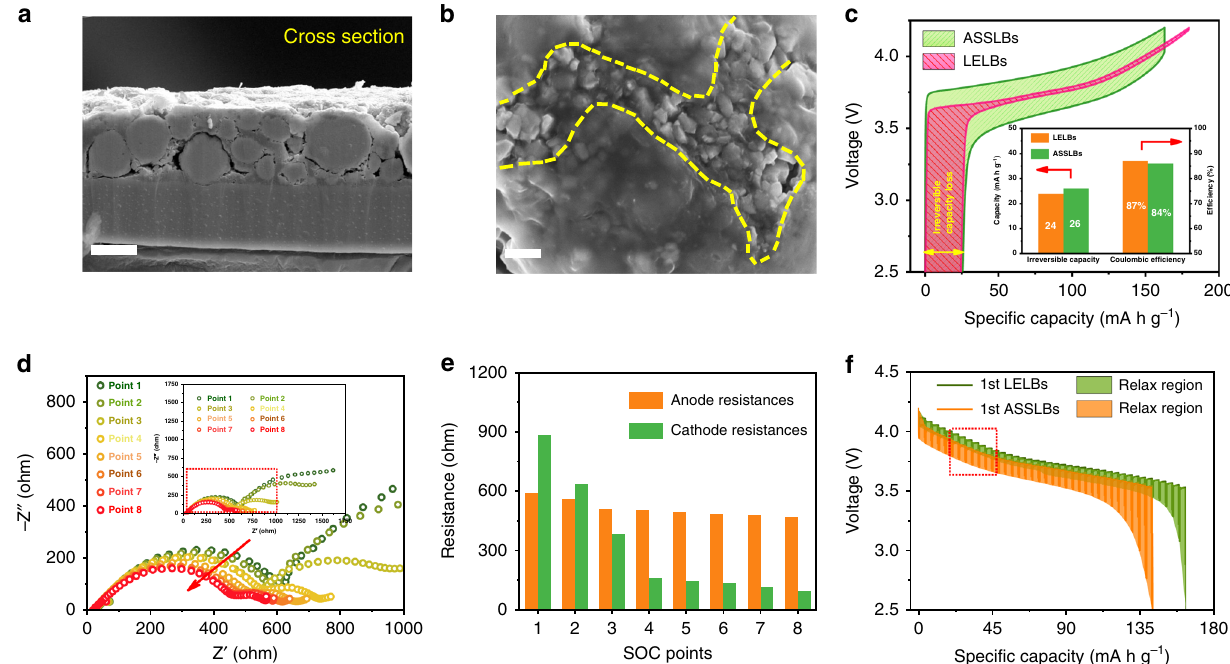
Fig. 1 Electrode morphology, microstructure, and electrochemical behavior of NCM in the ASSLBs. ( a , b ) Typical SEM images of the cross-section and surface of the actual NCM electrodes in the ASSLBs. Scale bar, 10 μ m, 2 μ m. ( c ) Charging and discharging pro fi les of the NCM cathodes in the ASSLBs and LELBs at 0.2 C, where the inset shows irreversible capacities and initial Coulombic ef fi ciencies of the ASSLBs and LELBs. ( d ) Evolution of the EIS results in the charging process, corresponding to the selected points in Supplementary Fig. 5a. ( e ) Fitting anode resistance and cathode resistance of the ASSLBs in the charging process. ( f ) GITT pro fi les of the NCM electrode in the ASSLBs and LELBs at different states of charge,